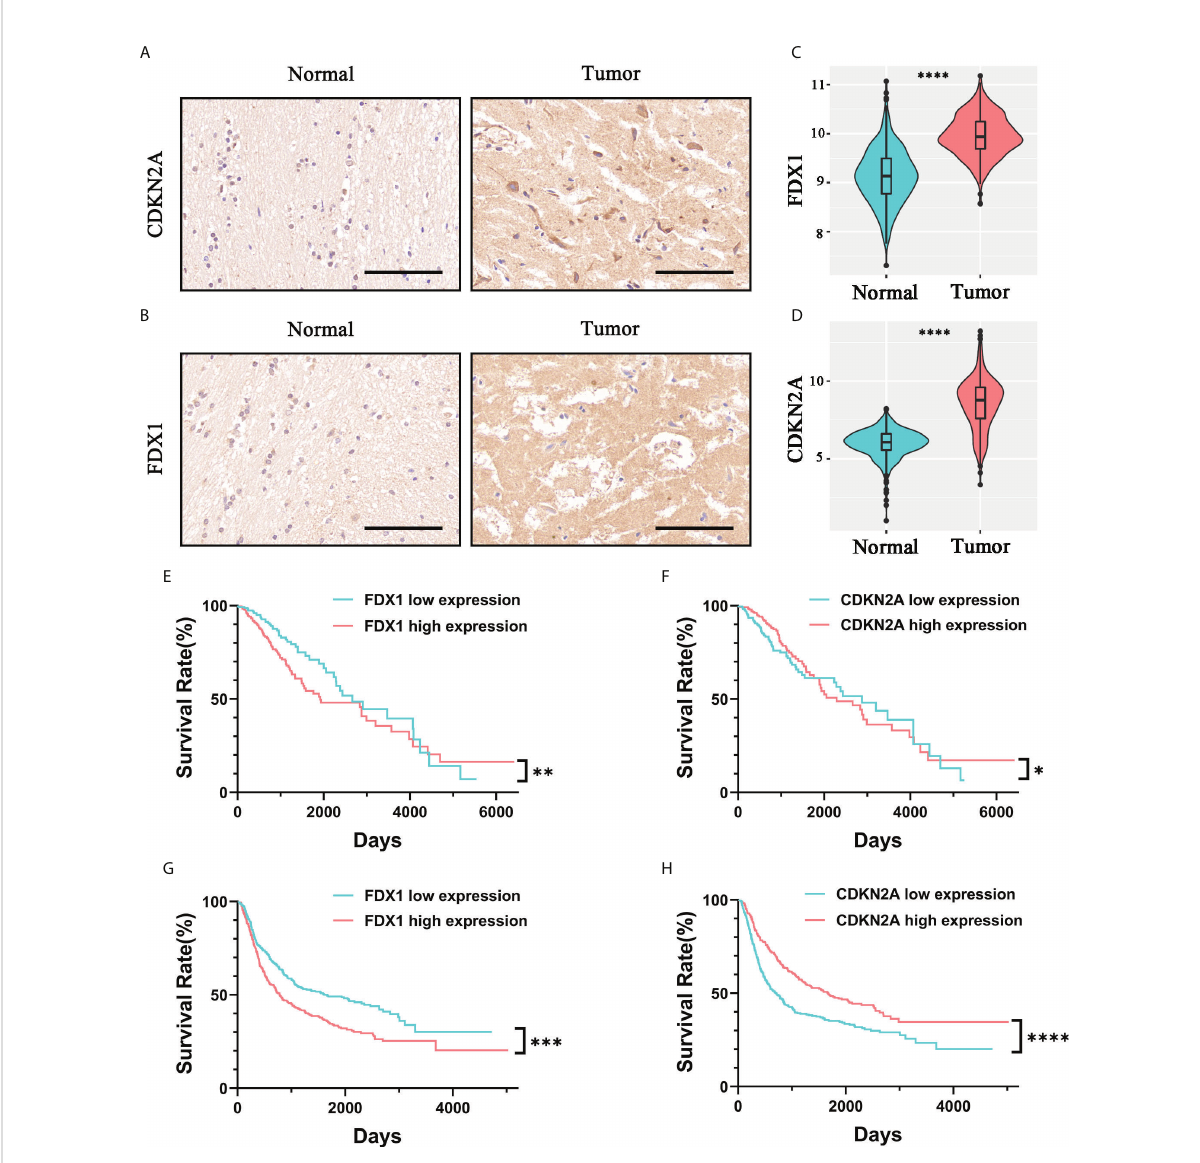
FIGURE 5 Validation of the prognostic value and expression of independent risk factors associated with prognosis in CARSs. The expression levels of CDKN2A (A) and FDX1 (B) in normal brain tissue and WHO 2/3 glioma tissue were investigated by immunohistochemistry. Scale bar, 100 m m. The expression levels of FDX1 (C) and CDKN2A (D) in normal brain tissue and WHO 2/3 glioma tissue were investigated in the TCGA cohort. **** P < 0.0001. (E, F) FDX1 and CDKN2A survival analysis of patients in the TCGA cohort. * P < 0.05; ** P < 0.01. (G, H) FDX1 and CDKN2A survival analysis of patients in the CGGA cohort. *** P < 0.001; **** P <